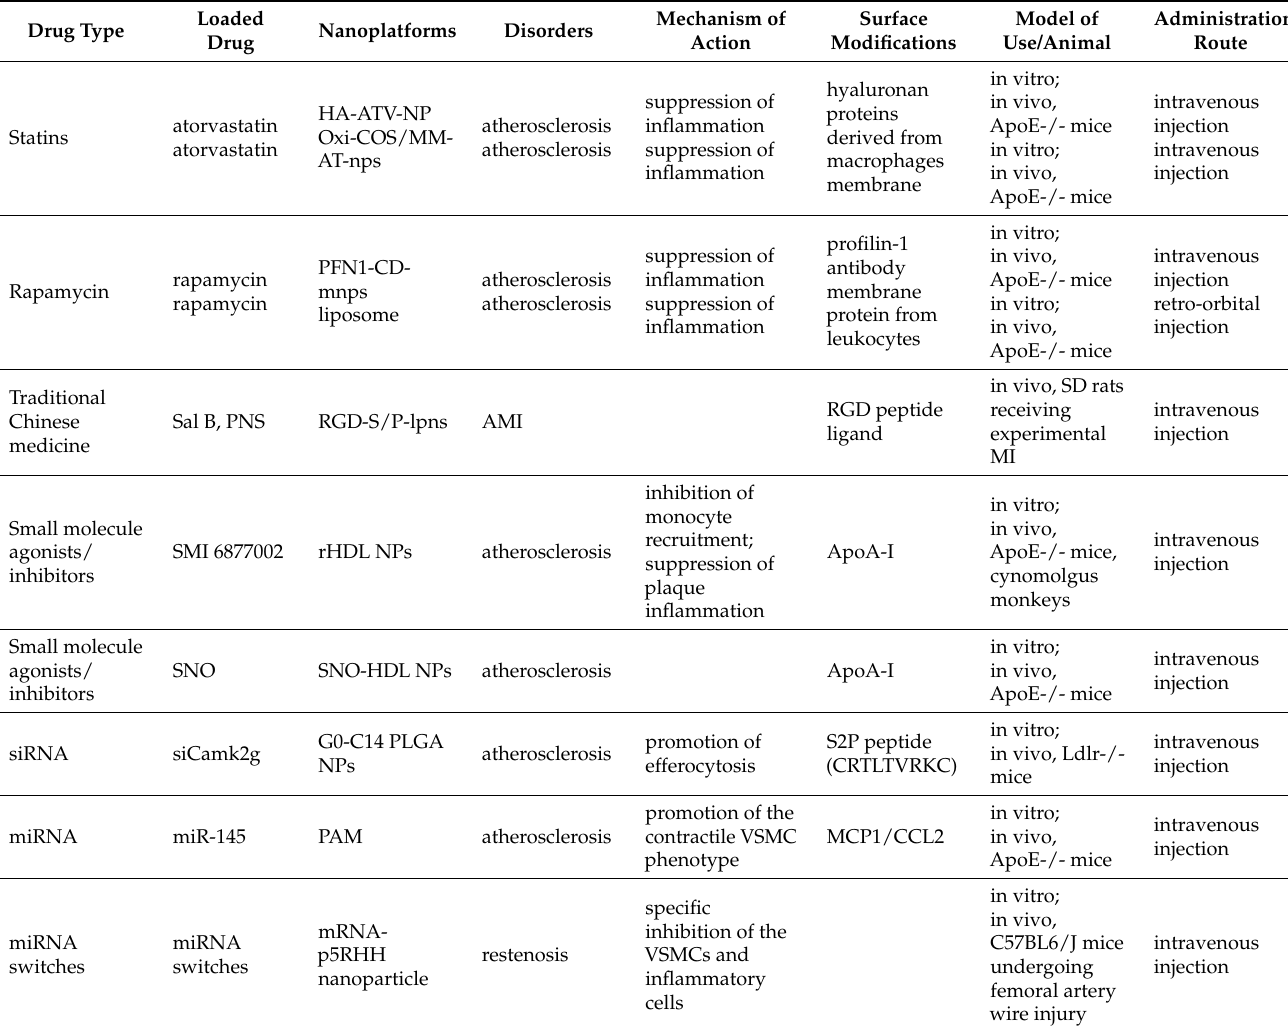
Table 1. List of nanoplatforms for target delivery of various drugs to the sites of cardiovascular diseases (CVDs). Table reproduced from Hu et al., 2022